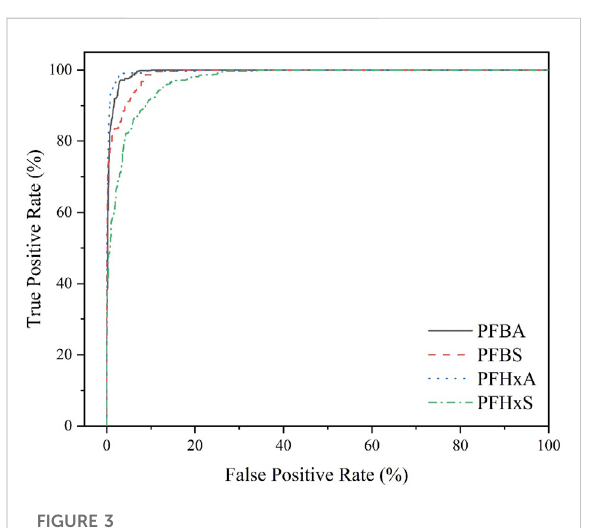
FIGURE 3 Receiver operating characteristic curves for short-chain PFAS.